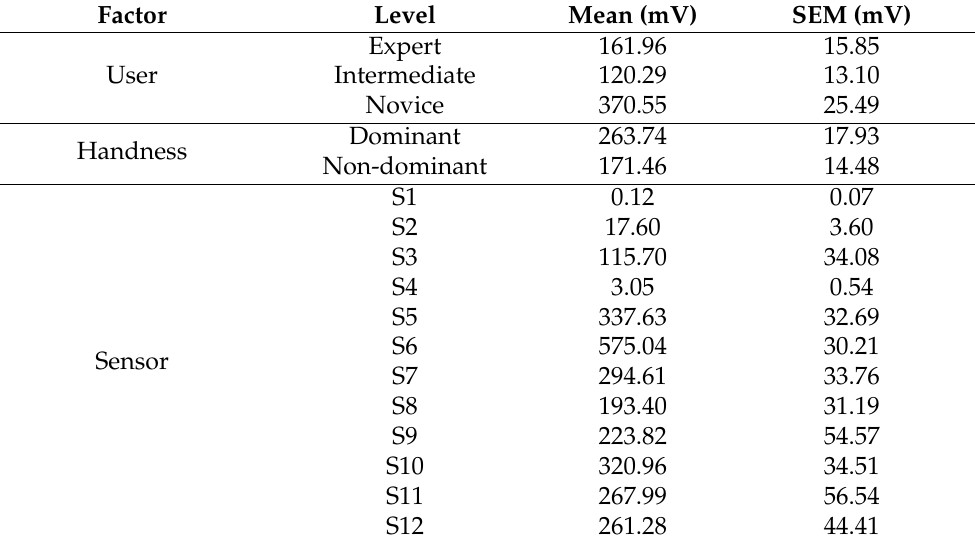
Figure 7. Force results for three users with dominant and non-dominant hands among ten sessions Table 8. Force Mean and SEM for all